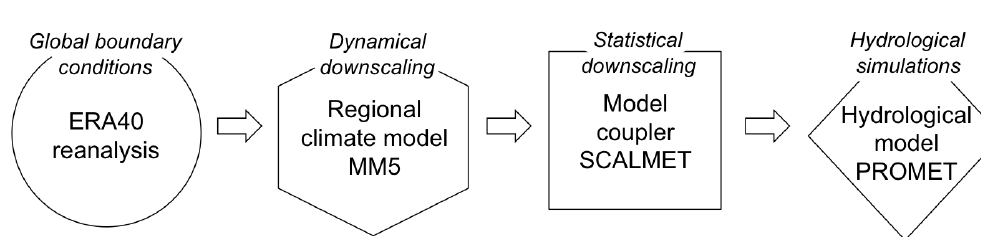
Fig. 2. Schematic overview of the hydrometeorological model chain.